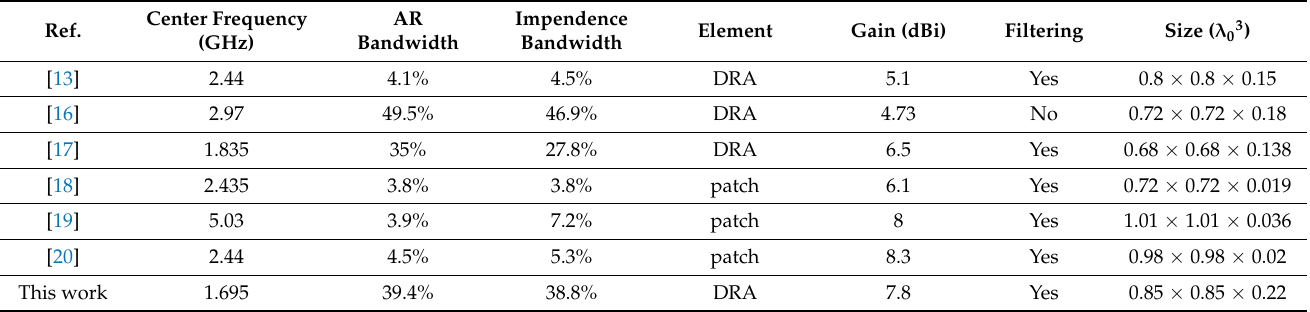
Table 1. Comparison between the proposed antenna and previously published works.